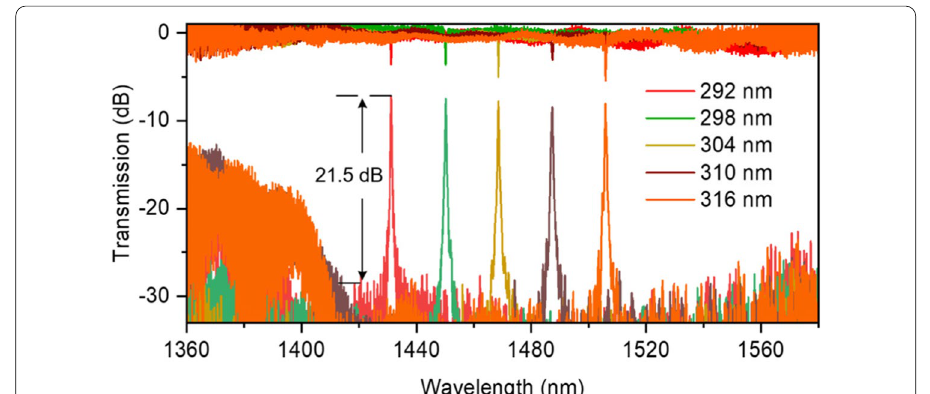
Fig. 5 Measured transmission spectra of the fabricated devices with various